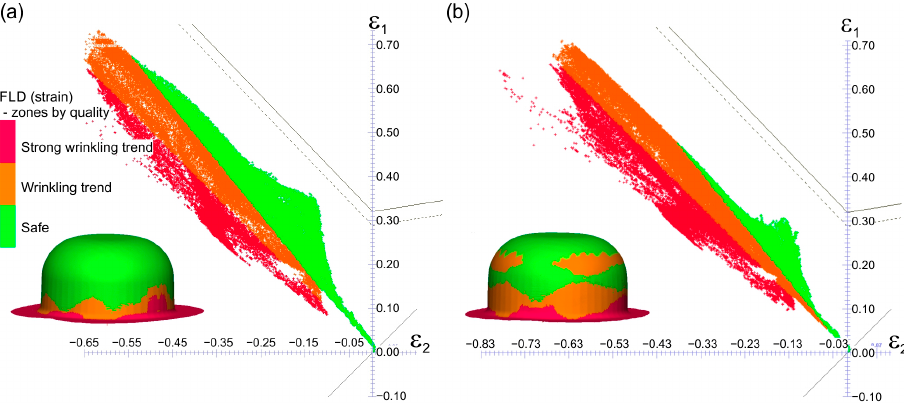
Figure 12. Evaluation of the deep drawing process using the forming limit diagram (zones by quality): ( a ) 1st variant of forming with dry friction; ( b ) 2nd variant of forming with lubrication.